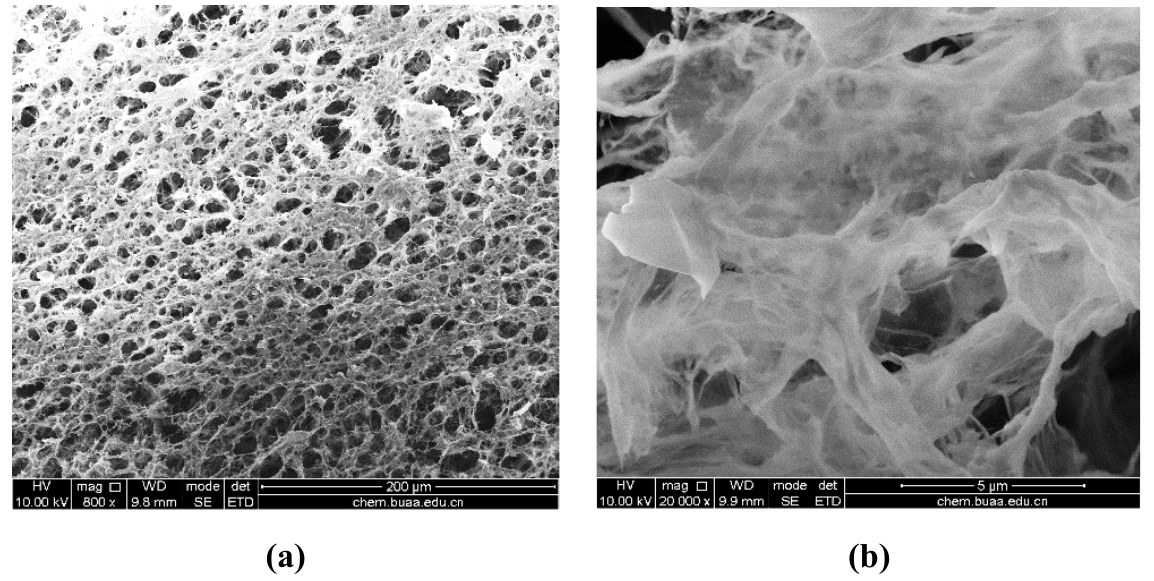
Figure 2: SEM images of GO: (a) magnification with × 800; (b) magnification with ×